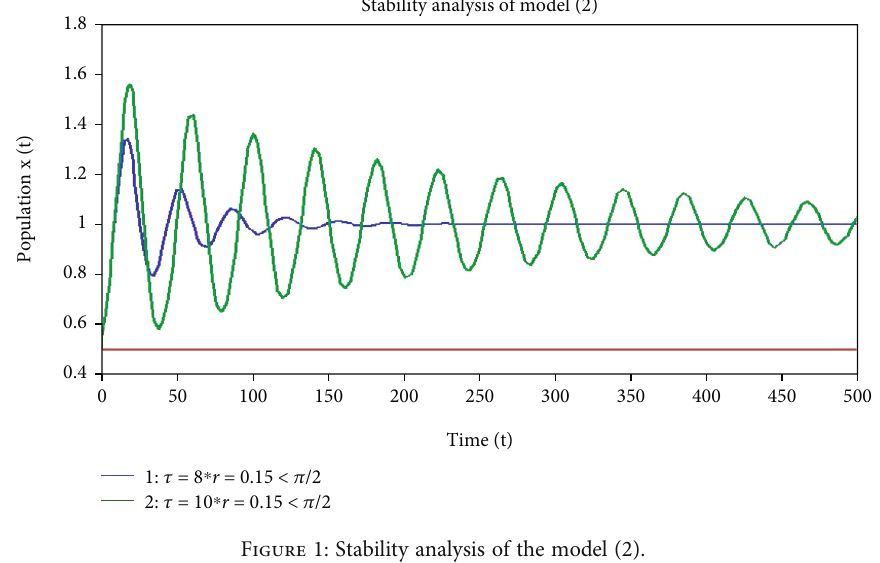
Figure 1: Stability analysis of the model (2).